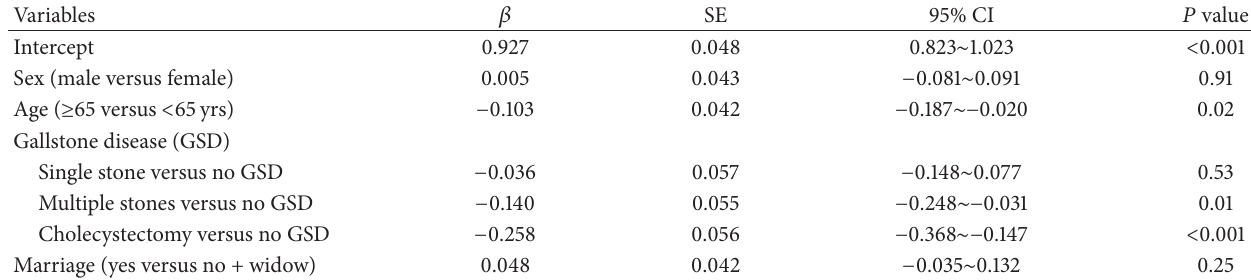
Table 4: Multiple linear regression on the associated factors related to the utility values that all univariate significant factors were included among outpatient clinics participants ( 𝑛 = 108